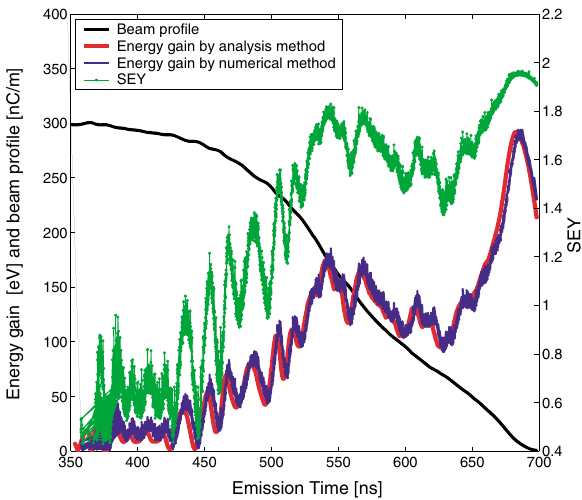
FIG. 4. (Color) Comparison of energy gain. The blue line is the energy evaluated numerically, the red line is the energy value obtained with Eq. (6), the black line is the beam’s profile, and the green line is the estimation of the